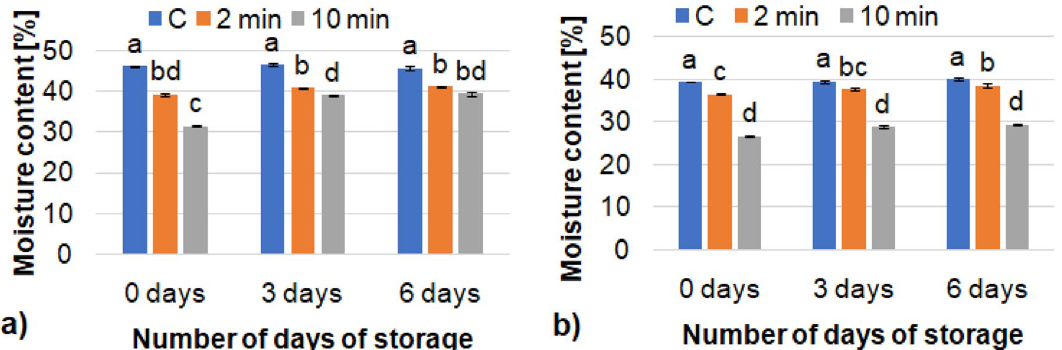
Figure 2. Moisture content of bread, ( a ) gluten-free bread, ( b ) mixed wheat-rye bread; mean values in the same figure marked with different letters are significantly (α = 0.05)